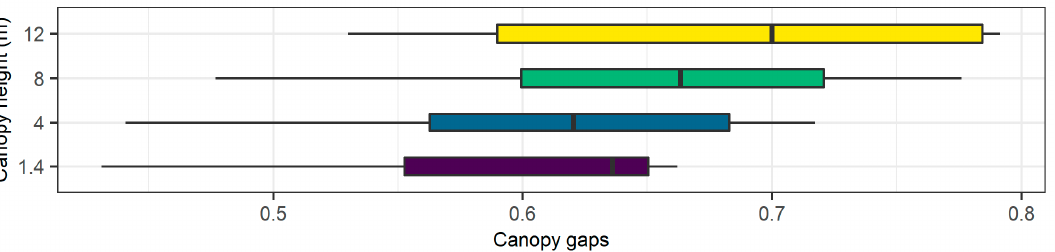
Figure 6. Canopy-gap estimates measured using digital hemispherical photography (DHP) in old growth longleaf pine ( Pinus palustris ). Canopy gaps and the variation associated with these esti- mates increase as canopy height increases. Estimates were derived from six transects using four measurement positions, or canopy heights, as indicated on the